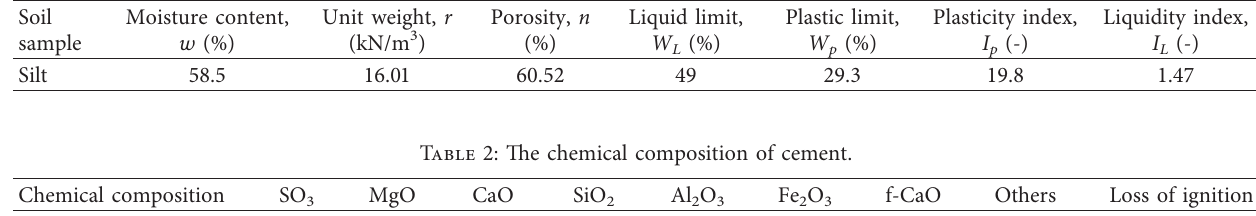
Table 1: The fundamental physical and mechanical indices of the silt soil.